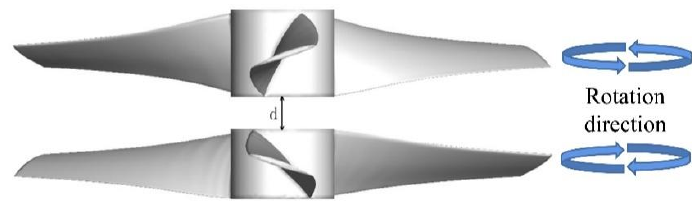
Figure 1. Designed coaxial